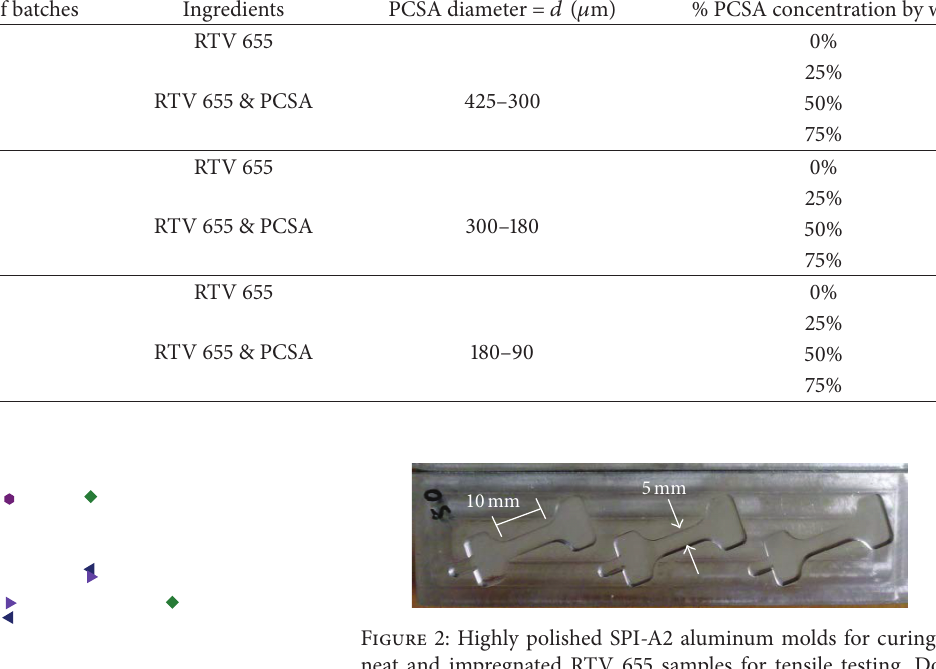
Figure 2: Highly polished SPI-A2 aluminum molds for curing of neat and impregnated RTV 655 samples for tensile testing. Dog- bones were cut according to ASTM D1708 geometrical specifica- tions.